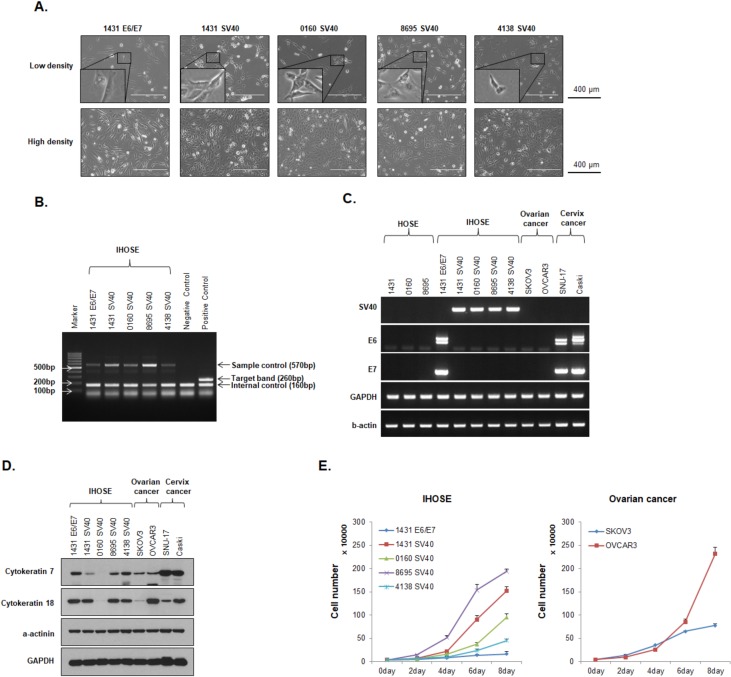
Characterization of five immortalized human ovary surface epithelial (IHOSE) cell lines.(A) Representative images showing the morphology of cells from five IHOSE cell lines. SE (Upper panel = Low density of cells; Bottom panel = High density of cells). Scale bar: 400 μm, 100× magnification. (B) Mycoplasm contamination testing was performed using 100 ng genomic DNA by RT-PCR. (C) The expression levels of SV40 T antigen and HPV E6/E7 protein in IHOSE cells were detected by RT-PCR. β-actin and GAPDH were used as loading controls. (D) The expression levels of indicated protein were determined by western blot analysis in the five IHOSE and cancer cell lines. β-actin and GAPDH were used as loading controls. (E) Cells (4 × 104) were seeded in a 6-well plate and counted every 2 days up to 8 days. Cell proliferation was determined using an automated cell counter. Results indicate cell number ± SD.